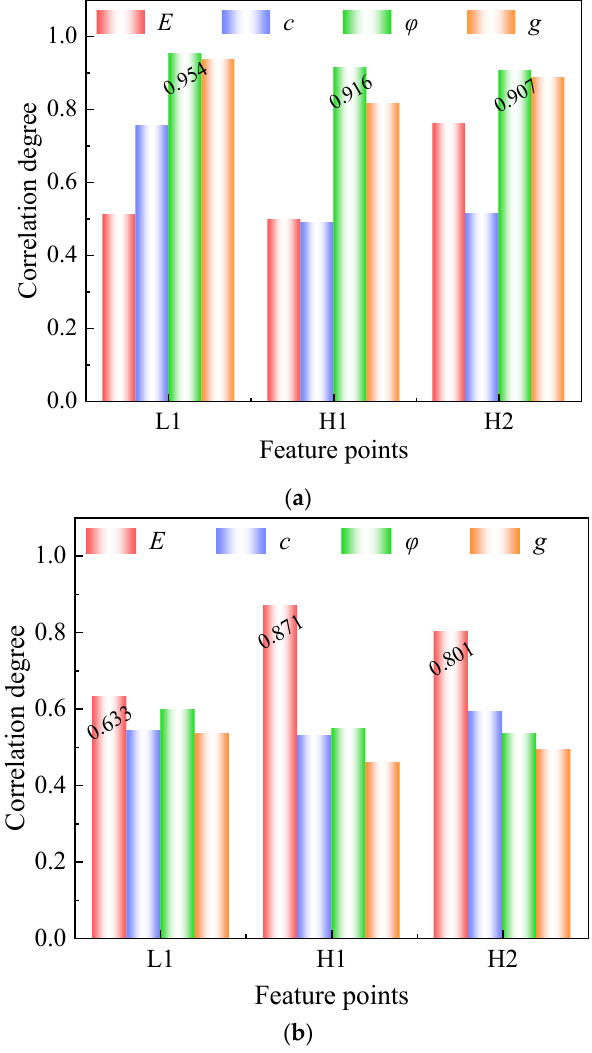
Figure 11. Soil feature point relational degree histogram. ( a ) Peak acceleration; ( b ) Lateral displace- ment extremes.